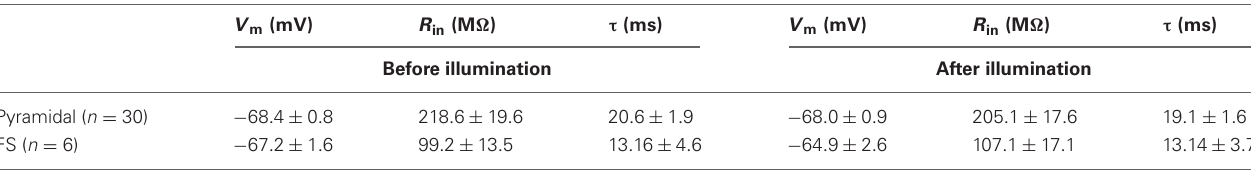
Measurements were taken before opening the fluorescent light shutter and 2min after the termination of a 5min illumination period. V m , resting membrane potential; R in , input resistance; τ , the membrane time-constant. Note the stability of parameters throughout the